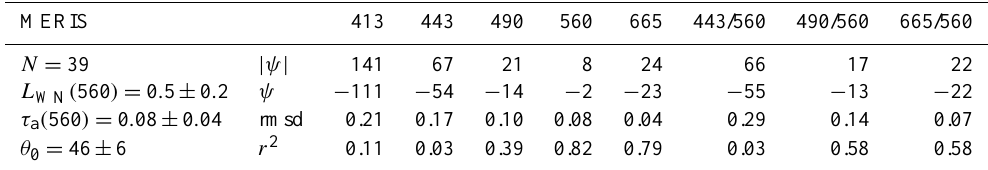
Table 5. Statistical results from the analysis of MERIS (3rd Reprocessing) and AERONET-OC L WN , and their ratios at specific center wavelengths for the match-ups determined at the GDLT and HLT with 1t = ± 2h. Symbols and units are the same as in Table 1.